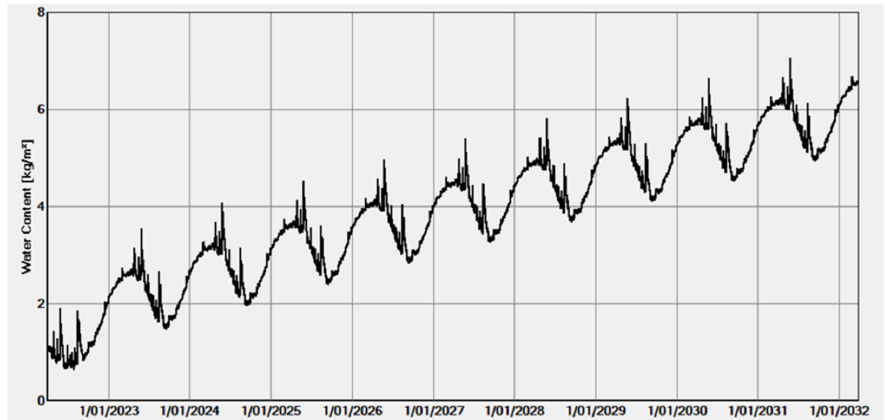
Figure 15. The 10-year fluctuation of moisture content for the wall assembly in northern orientation for pliable membrane D and E.